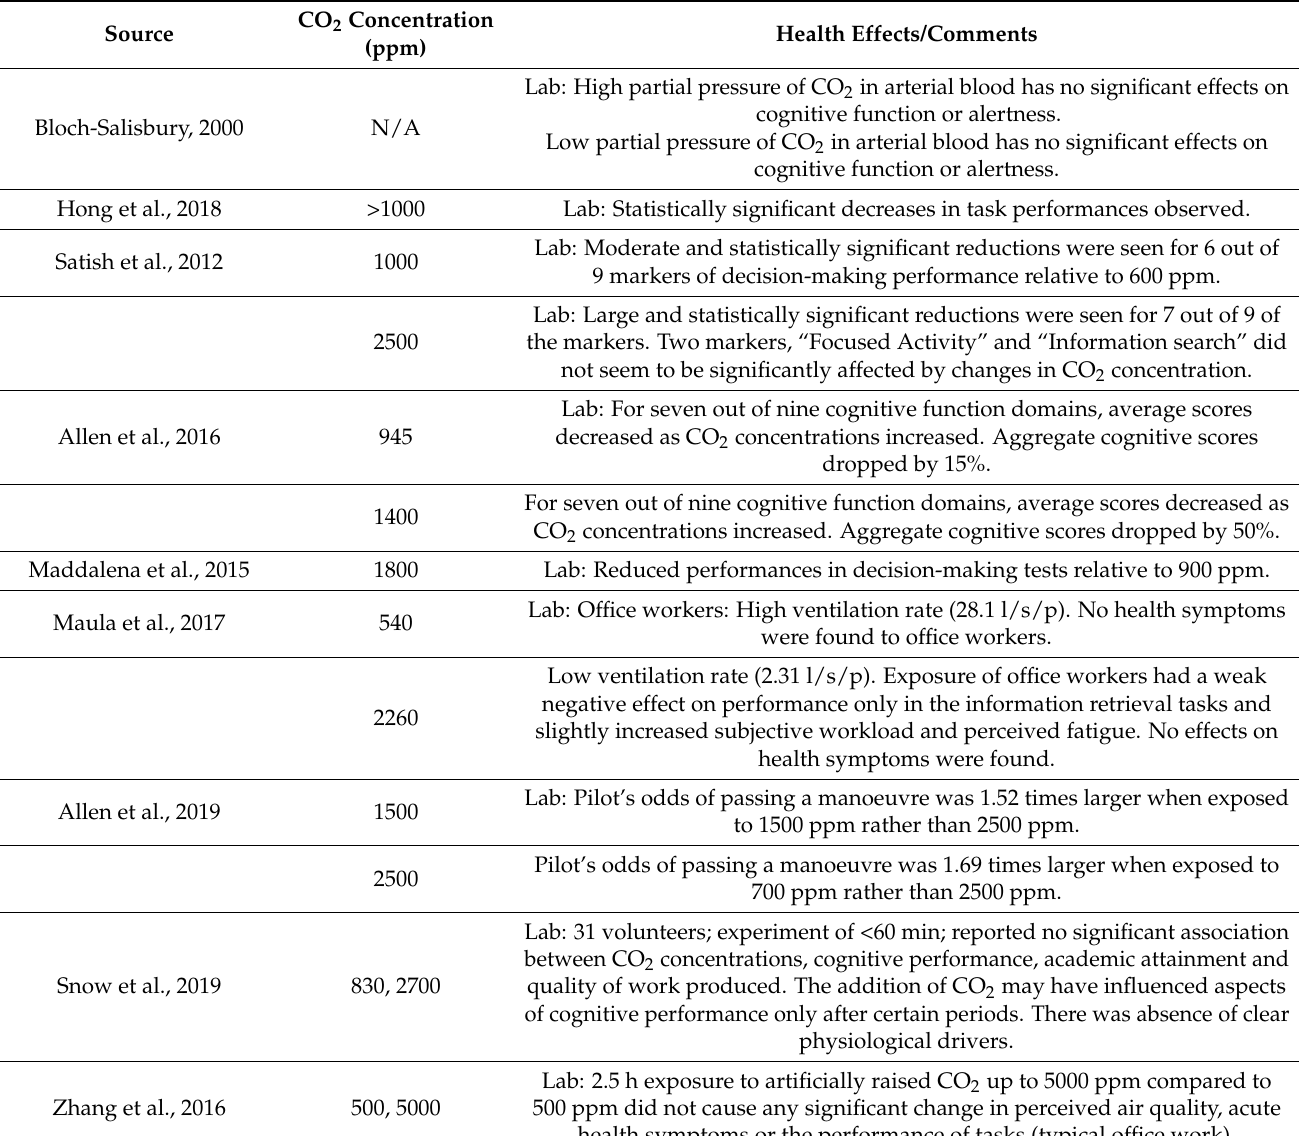
Table A2. A summary of primary research associating CO 2 with cognitive performance